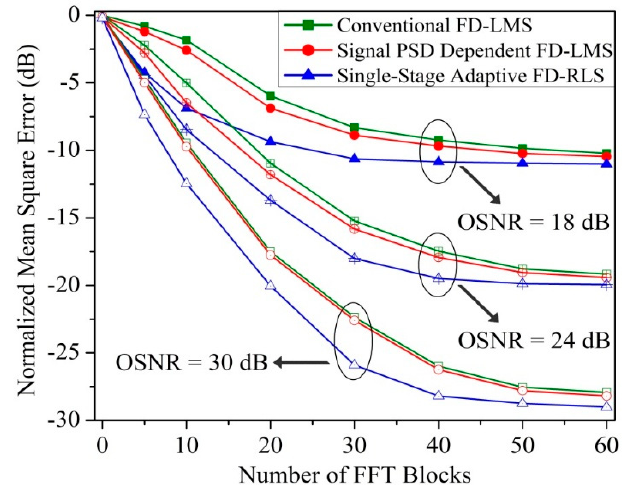
Figure 29. The convergence speed comparison of two FD-LMS algorithms and single-stage FD-RLS algorithms at different OSNRs [7].